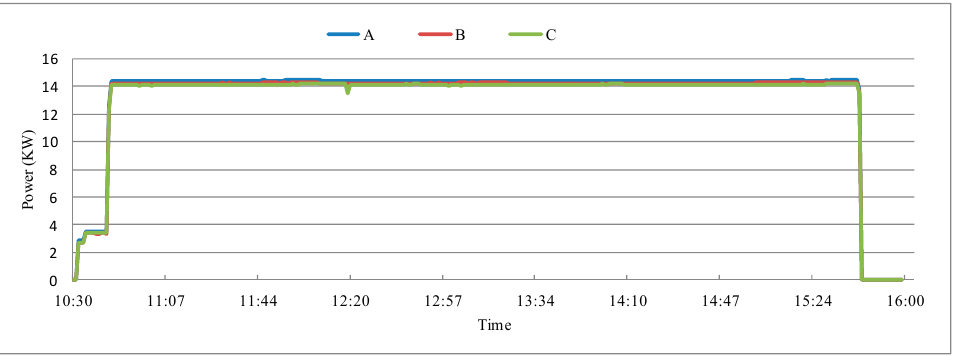
Figure 2. The measured three-phase charging power.